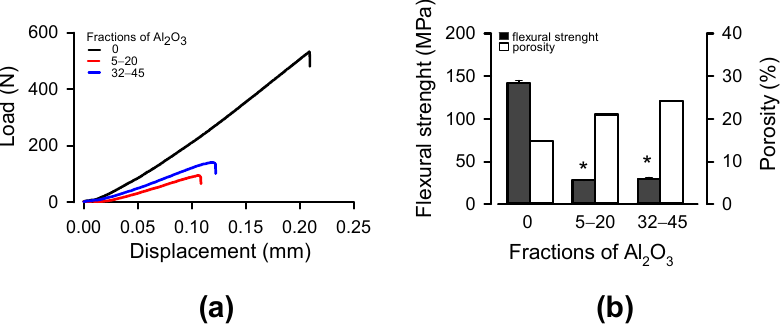
Figure 10. Flexural strength of oxidized samples. ( a ) Load–displacement curves recorded during the 3 ‐ point bending test for Ni and Ni/Al 2 O 3 samples; ( b ) Correlation between the flexural strength and open porosity. * Significant versus the Ni sample.